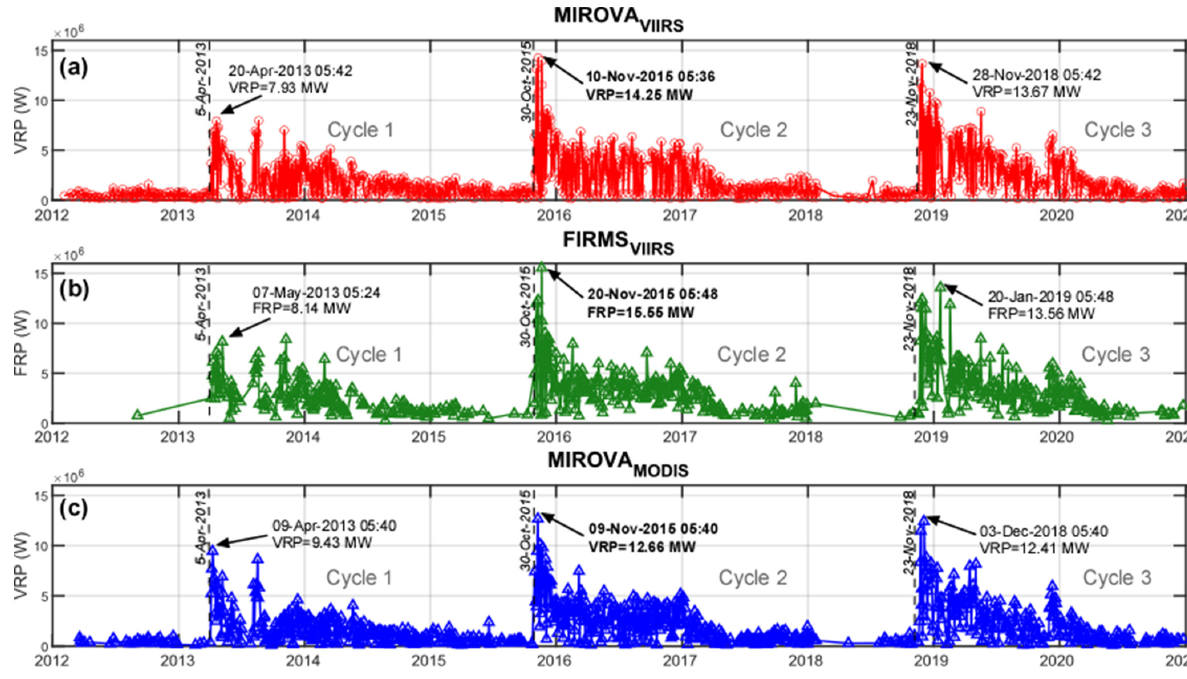
Figure 4. Time series of Láscar volcano. The panels show VRP calculated respectively from ( a ) MIROVA VIIRS (red circles), ( b ) FIRMS VIIRS (green triangles), and ( c ) MIROVA MODIS (blue triangles). The black dashed lines represent the date on which a sudden change in the VRP, associated with the beginning of a cycle, was detected by the three datasets. The arrows highlight the peaking VRP recorded during the following days. Note that, even if the high thermal phases reach their maximum detections on a different day, the inferred onset is detected by all systems within a time window of 24 h, with few differences in magnitude, probably due to instrumental and algorithm-related features.